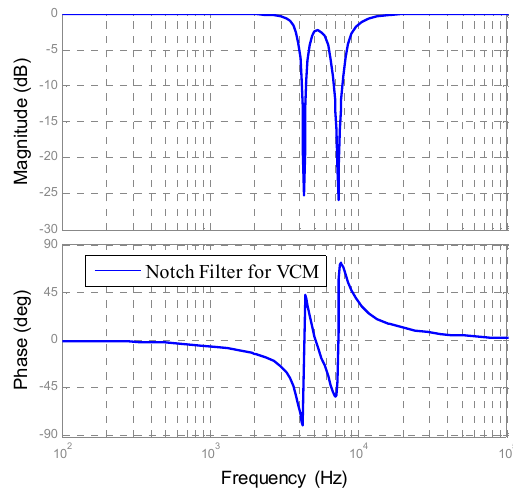
Figure 11. The frequency response of a notch filter for VCM.